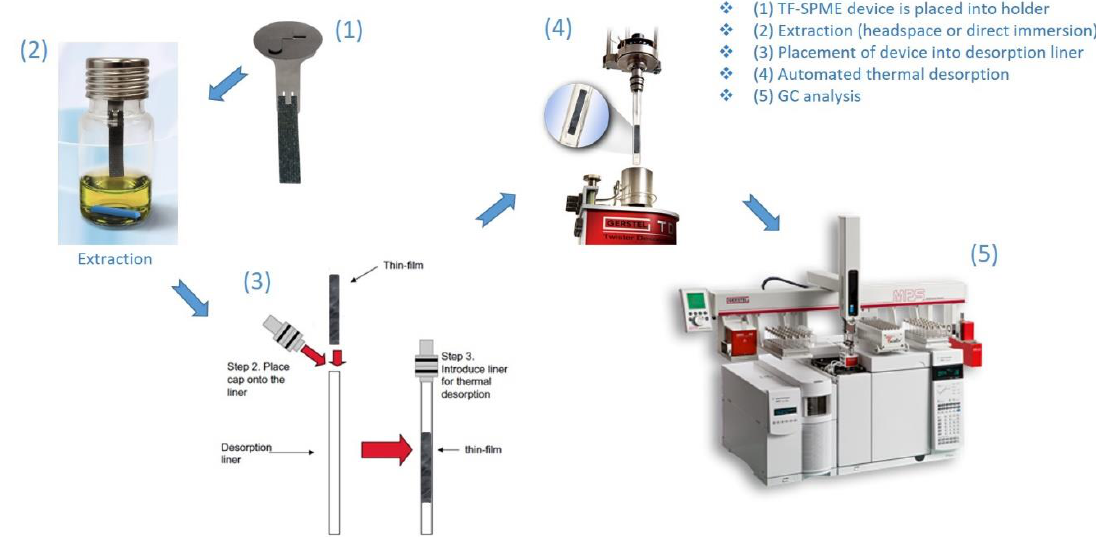
Figure 2. Optimized TF-SPME workflow (photos courtesy of GERSTEL Inc.) for extraction and thermal thermal desorption.